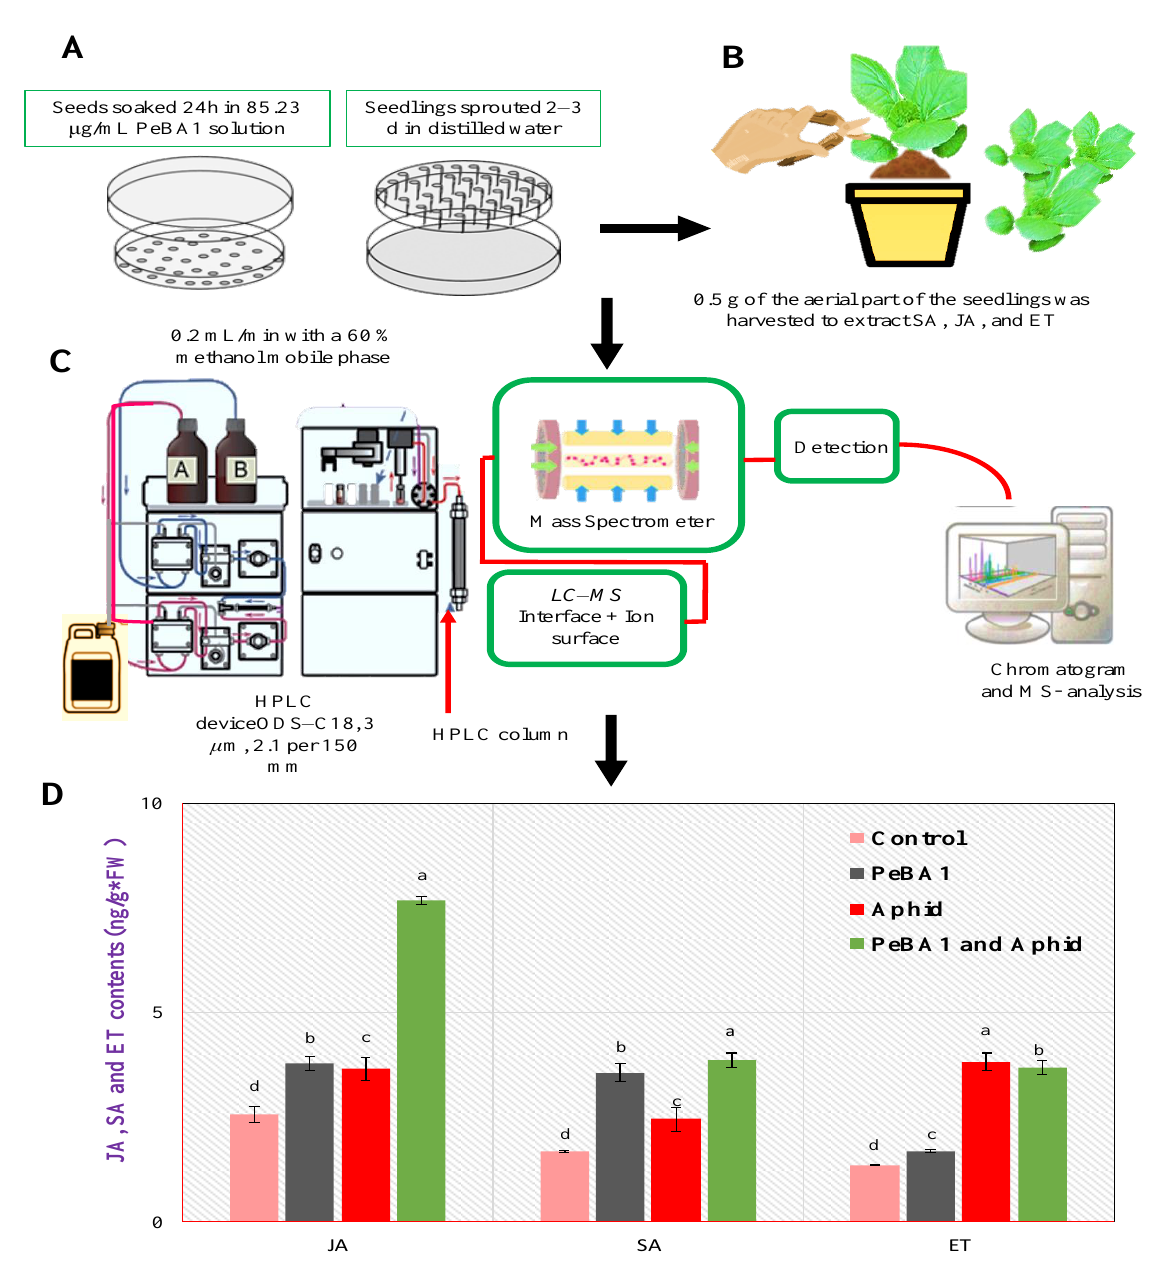
Figure 8. Seed and seedling treatment ( A ), aerial part of seedling was harvested to extract JA, SA, and ET ( B ). JA, SA and ET contents in B. rapa seedlings (mean ± SD) ( C , D ). PeBA1-treated tests were gathered 1 d after the spraying. Aphids were inoculated on seedlings 1 d after they were sprayed with treatment, and samples were collected 1 d after they were inoculated, (a–d) are significant differences among treatments and control, Data were compared statistically; the LSD, ANOVA, and Leven’s test were employed by Statistix version 8.1. ( p = 0.05).